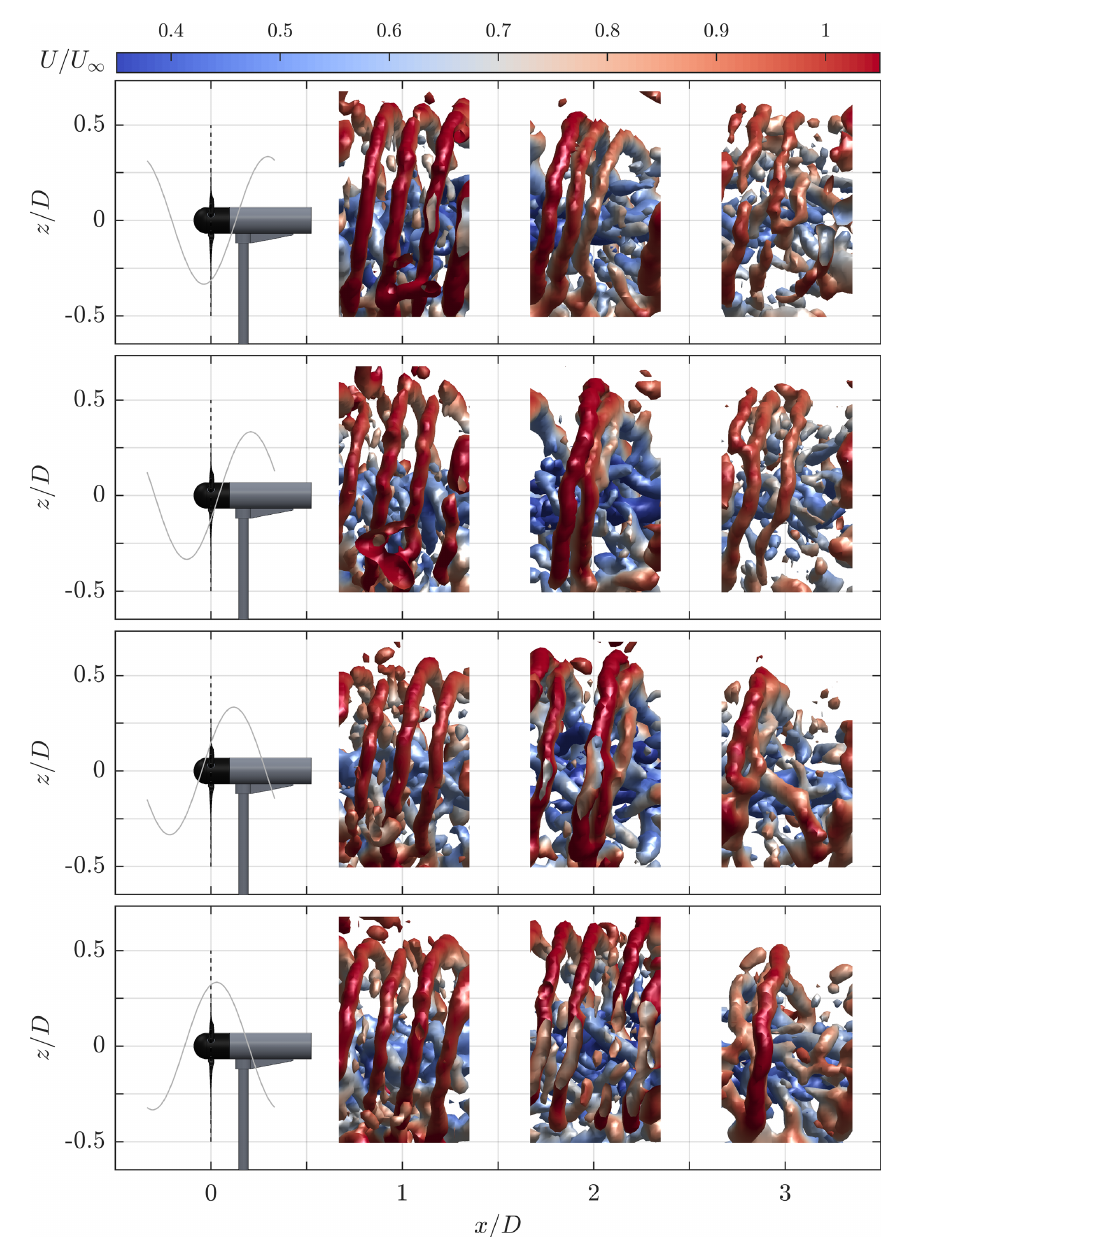
Figure 14. Isosurfaces of the instantaneous normalized Q criterion ( QD 2 /U 2 ∞ = 1) visualizing the blade tip vortices for operation with DIC ( St = 0 . 19). The different snapshots are separated by (cid:49)t = 0 . 1s. The colors of the isosurfaces correspond to the normalized streamwise velocity component, while the gray line indicates the current pitch